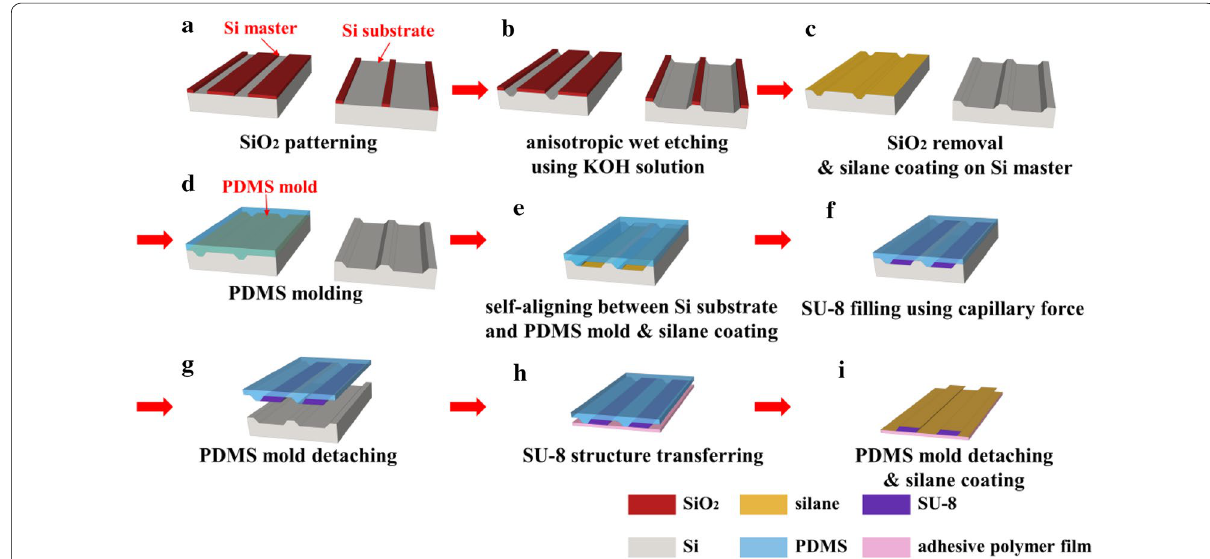
Fig. 2 Schematic view of the fabrication process of anisotropic wetting surface with parallelogram structures